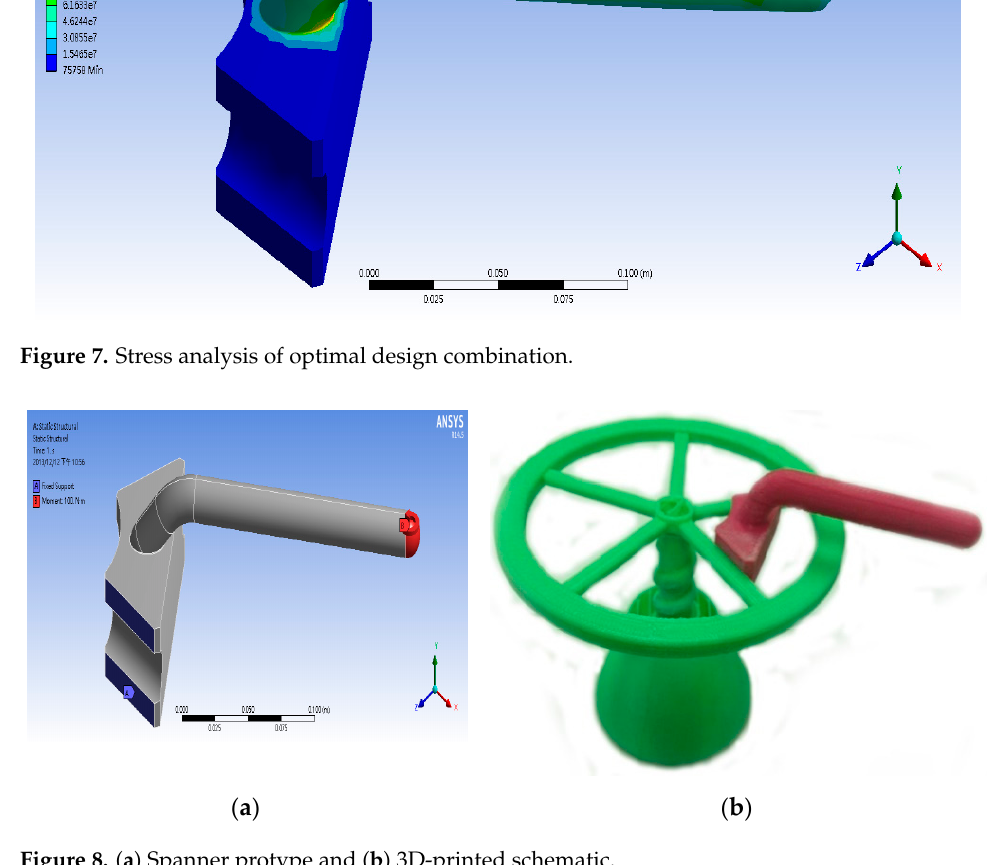
Figure 8. ( a ) Spanner protype and ( b ) 3D-printed schematic.